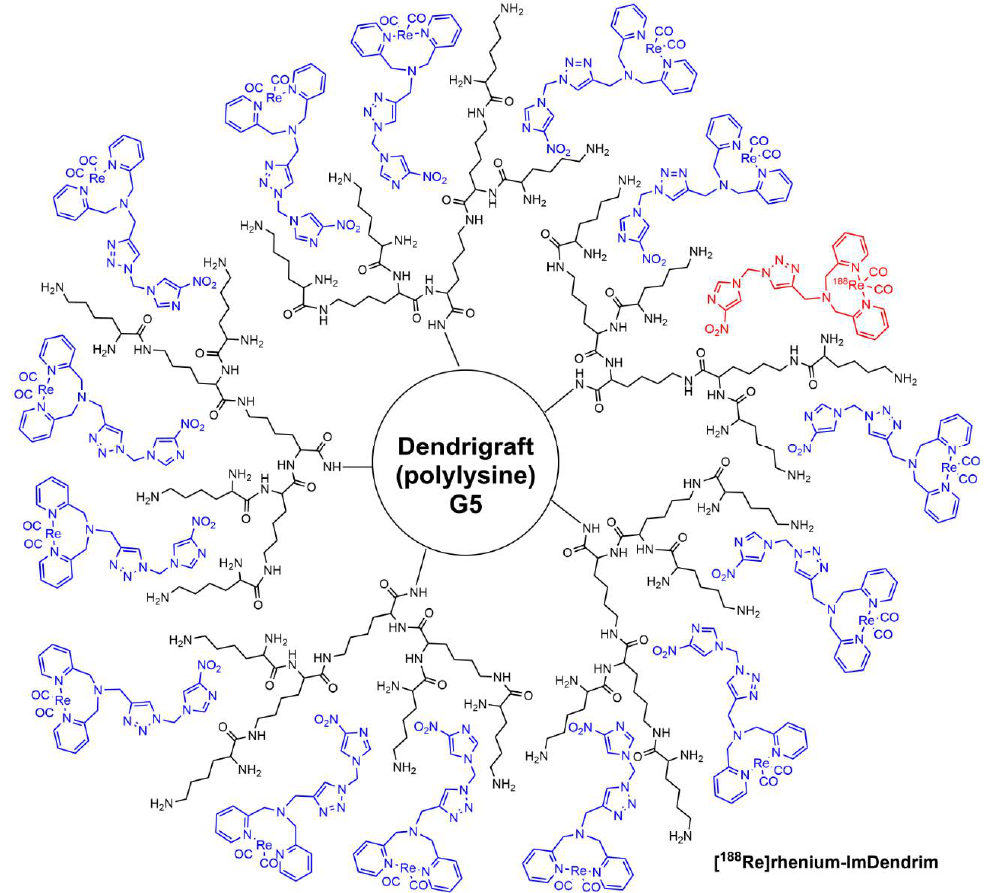
Figure 4. Schematized structure of [ 188